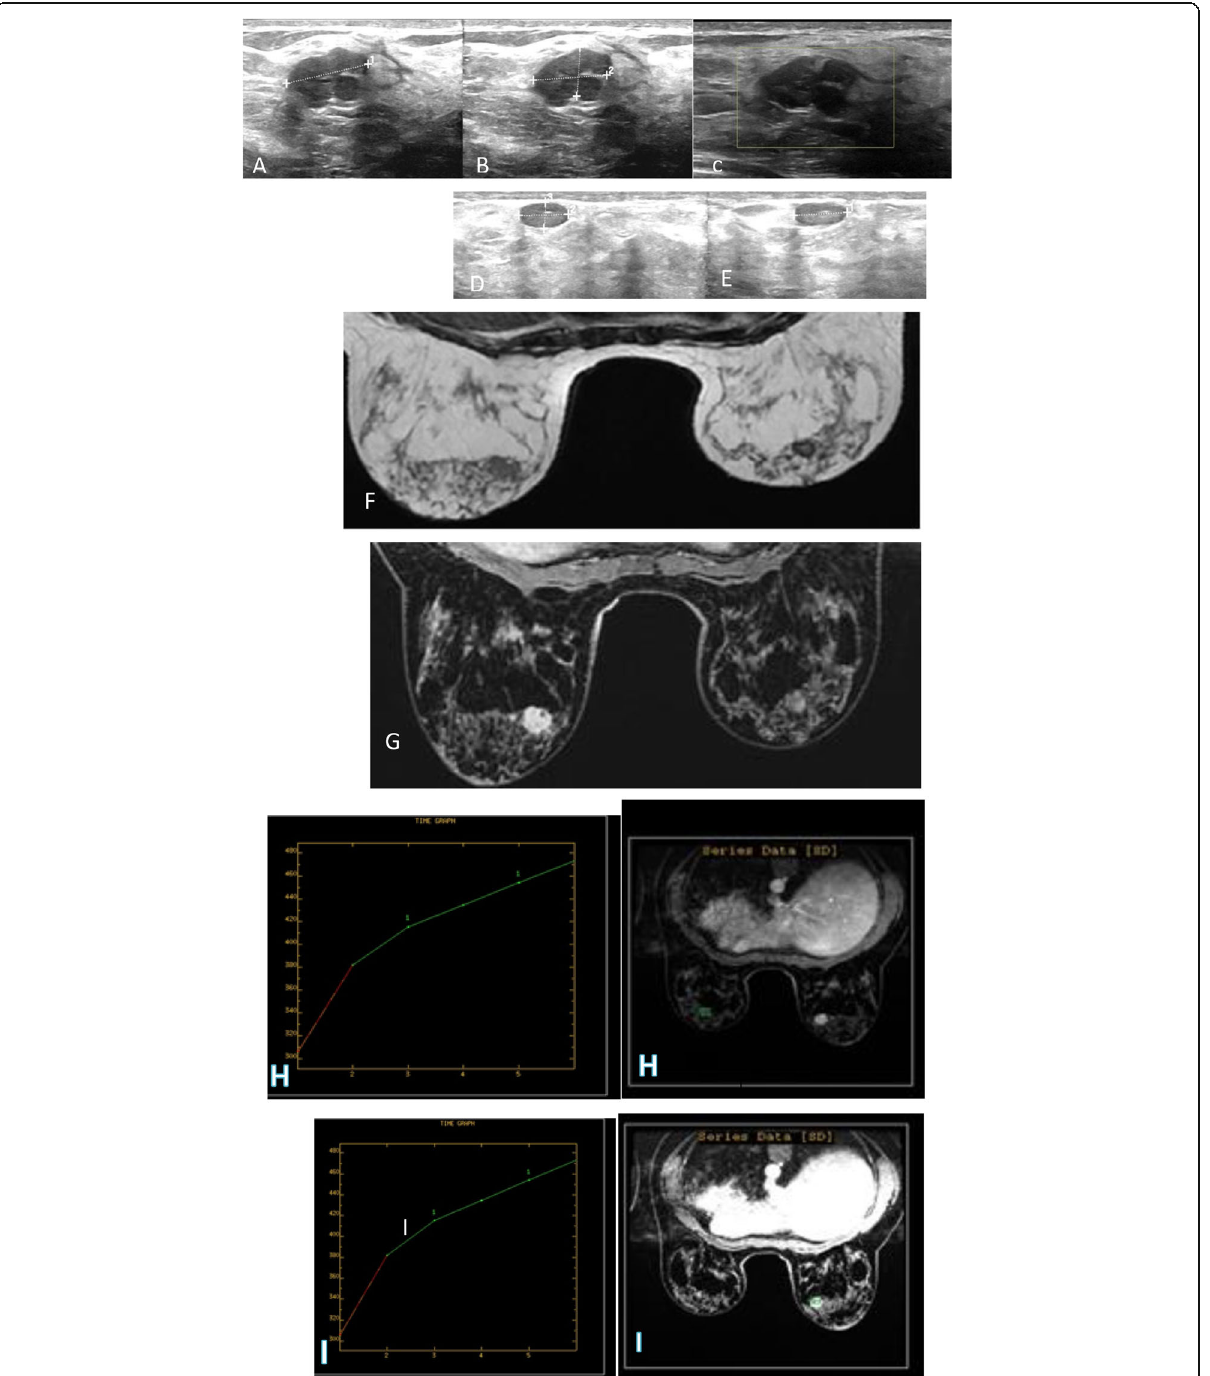
Fig. 8 A 25-year-old patient with history of bilateral breast lumps and strong family history of CA breast. Right breast mass ( a and b ) US shows hypoechoic mass (BIRAD II), c 3-month follow-up shows increasing in size and more lobulation (change to BIRADS III). The left breast mass ( d ) US shows smooth outline hypoechoic mass (BIRAD II , e 3-month follow-up shows no significant changes (BIRAD II). f and g MRI, T1, and post- contrast study detected the masses in both sides, the right one is lobulated and the left one is smooth margin, h and i ) images revealed that the right mass shows type I enhancement pattern in kinetic time intensity curve (BIRAD III) and the left mass shows type I enhancement pattern in kinetic time intensity curve (BIRADS II). Biopsy confirmed fibro adenoma on both